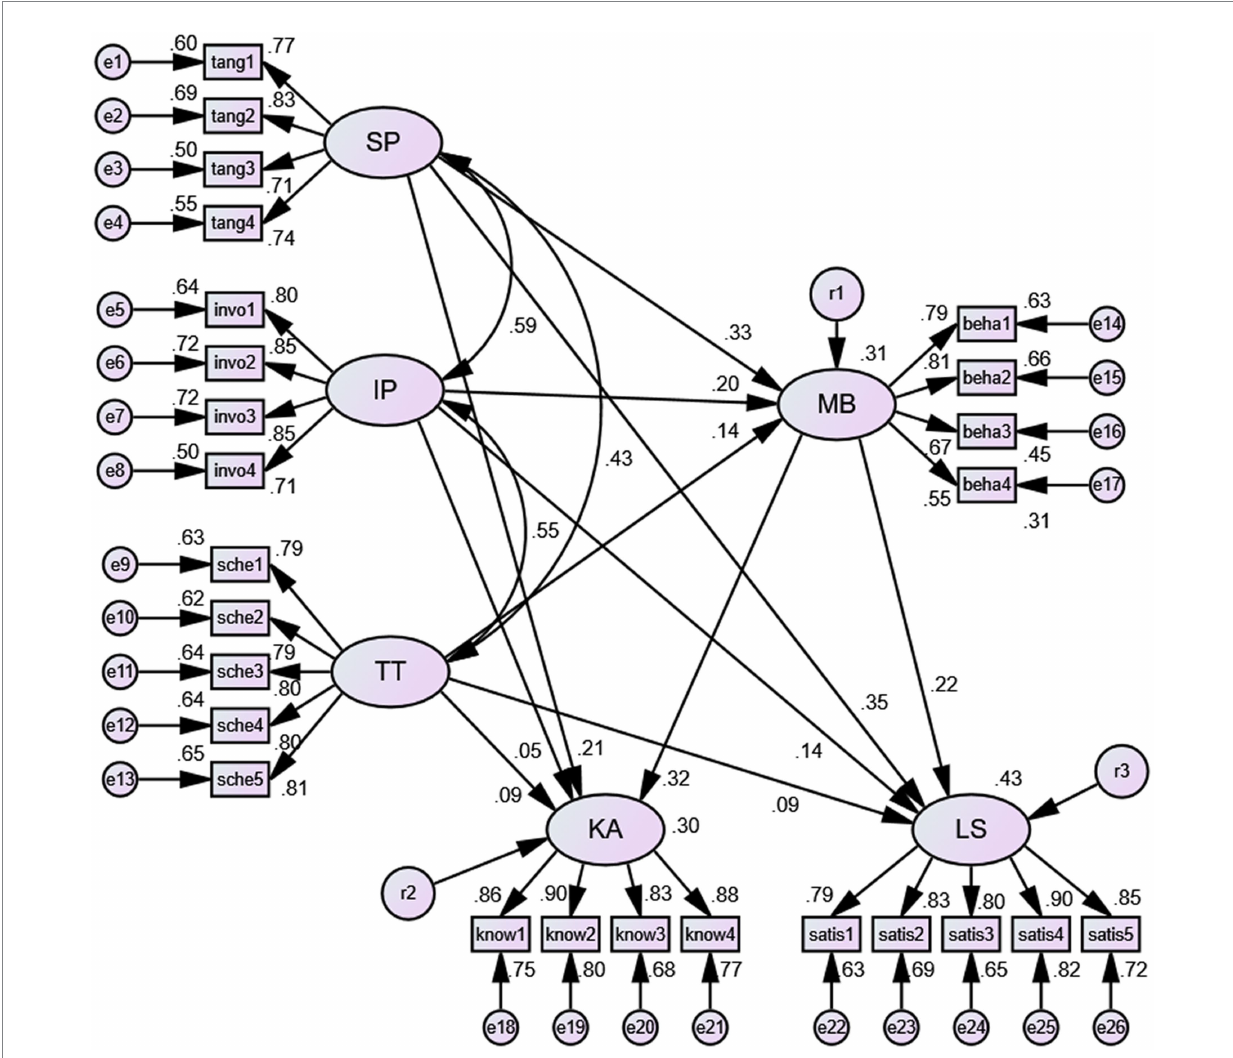
FIGURE 1 The standardization coefficient pattern of the SEM. SP = Scheduling preference, IP = Involvement with people, TT = Time tangibility, MB = Multitasking behavior, KA = Knowledge acquisition, LS = Learning